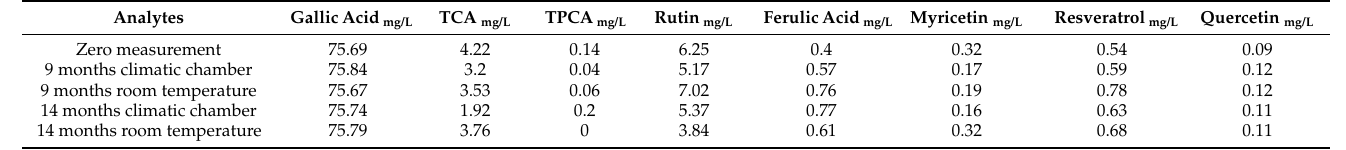
Table 17. Biologically active substances . Sample E—Pinot noir dry, harvest 2016.